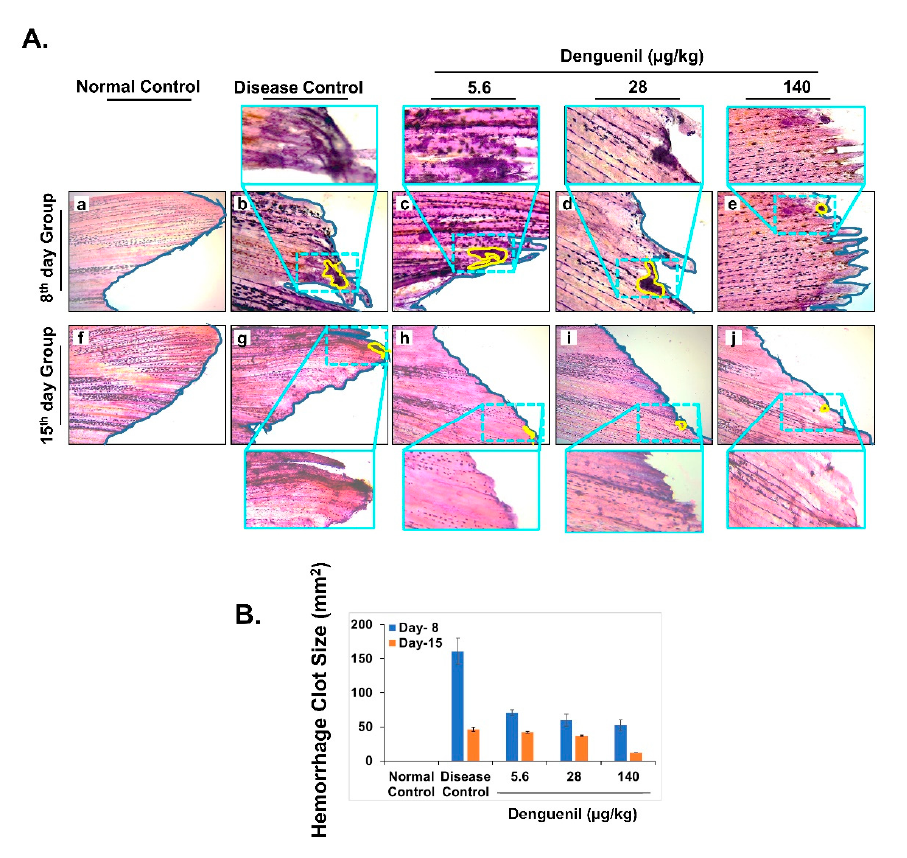
Figure 5. Pharmacological treatment with Denguenil inhibits dengue-virus-induced hemorrhage. Zebrafish caudal fins were harvested from all the groups at the end of the experiment and analyzed for dengue-virus-induced hemorrhage, at the 8th day and 15th day time points. ( A ) H&E stained caudal fin anatomy. 5A. ( a , f ) Normal Control. 5A. ( b , g ) Disease Control. 5A. ( c , h ) 5.6 µ g / kg Denguenil. 5A. ( d , i ) 28 µ g / kg Denguenil. 5A. ( e , j ) 140 µ g / kg Denguenil. The Caudal fin areas with observed hemorrhage and clots (marked in yellow) have been zoomed expanded for clarity. Original magnification, 10 × , zoomed in magnification, 40 × . ( B ) Quantification of hemorrhage clot size, averaged across each treatment group and respective time points.